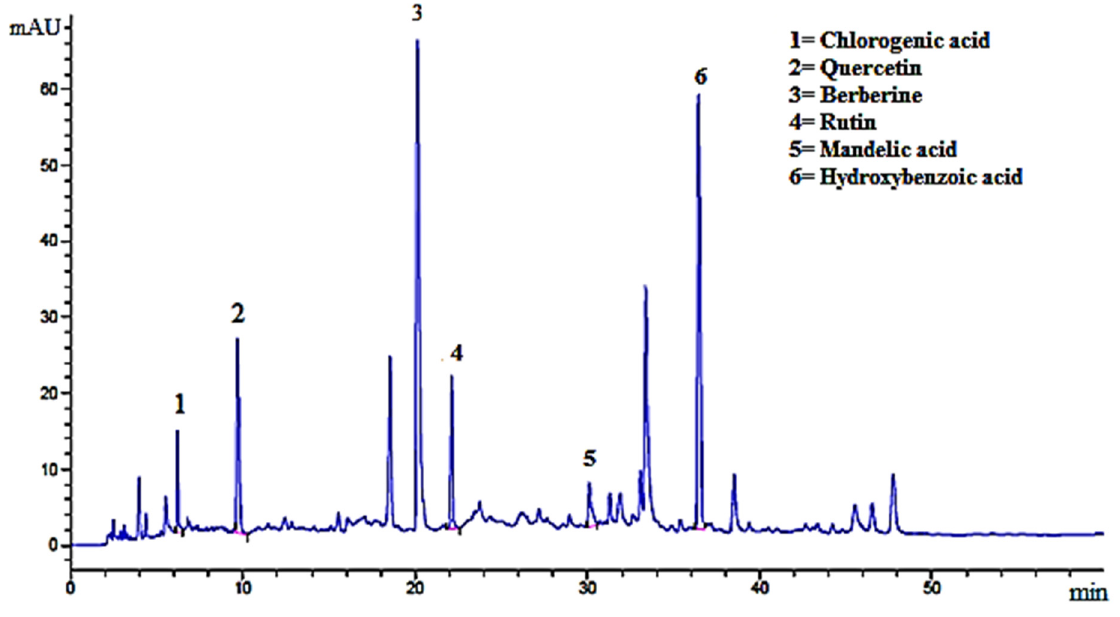
Figure 2. HPLC-UV chromatogram of Berberis lyceum Royle root Me. Ext. Table 4. Identified phenolic compounds in Berberis lyceum root Me. Ext.